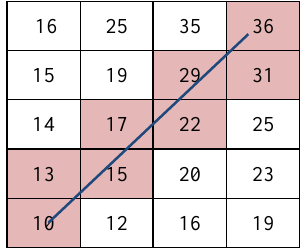
Figure 4. DTM heights in a small local window, encoded by integer numbers. The upper right and the lower left corner of the window coincide with two junction points which are connected by an edge (blue line). The pixel values fulfil the second criterion: from the lower left corner to the upper right corner the height values grow continually (10-13-15-17-22-29-31-36).